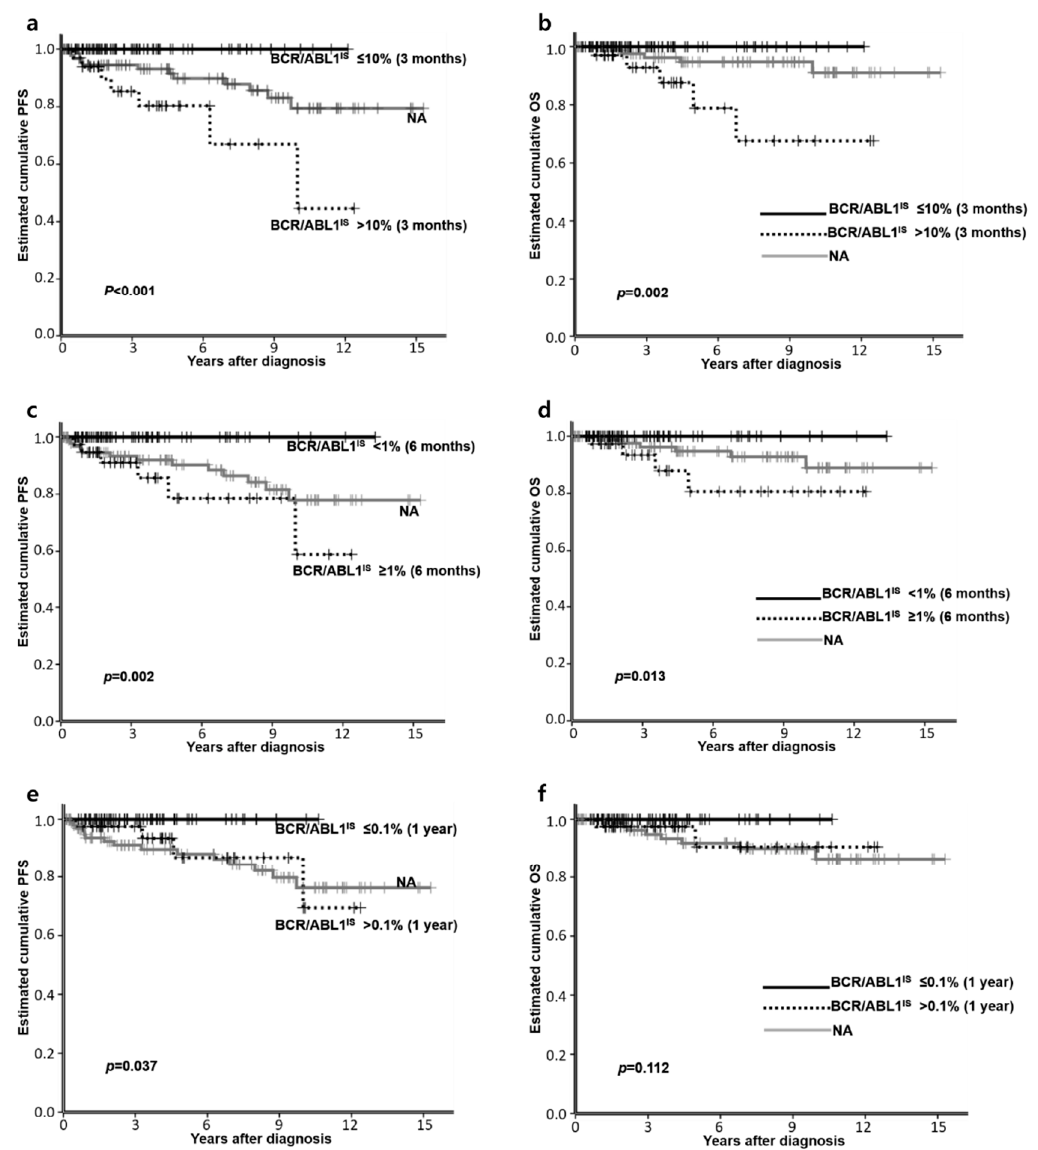
Figure 2. Event free survival (PFS) and overall survival (OS) depending on BCR/ABL1IS at 3 months ( a , b ), 6 months ( c , d ), and 12 months ( e , f ). All p values are calculated using the log-rank test with available data only.